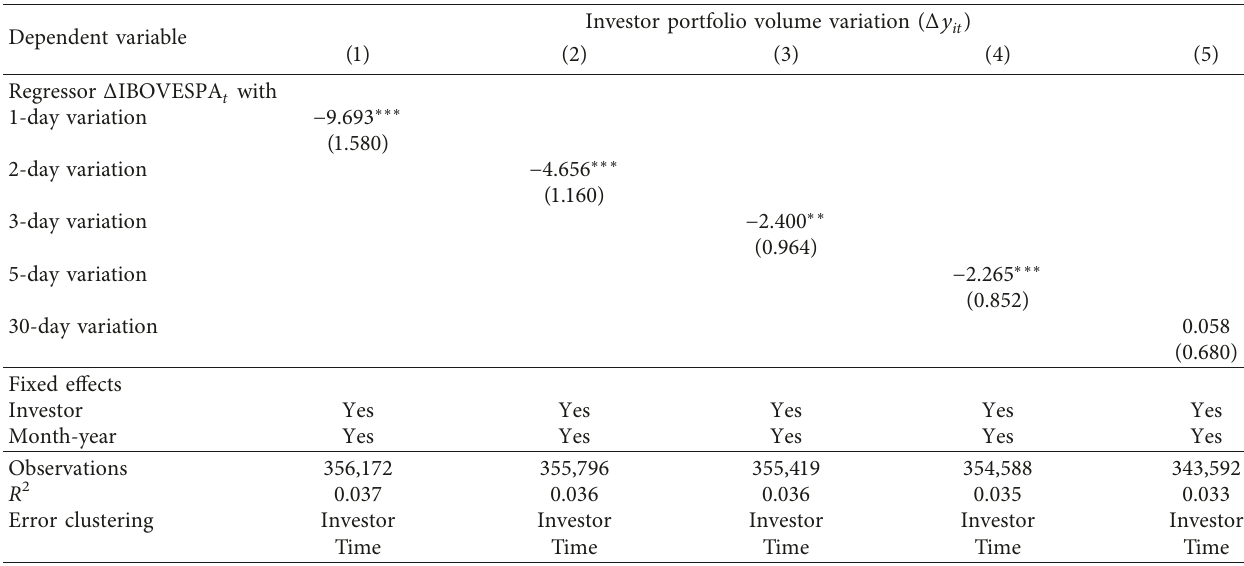
Table 2: Output from Regression (4). We ask how investors respond to changes in the IBOVESPA index. We only use changes rather than past averages because the former has greater prediction power as reported by our feature selection procedure. The dependent variable is the variation of portfolio investment volume of investor i at time t in the Brazilian stock market from the beginning of 2016 to the end of 2018. Regressors are 1- (1), 2- (2), 3- (3), 5- (4), and 30-day (5) IBOVESPA index variations. The panel is on a daily frequency basis. Following Petersen [50], we double-cluster standard errors at the investor and time levels. Significance levels: ∗ p < 0 . 10, ∗∗ p < 0 . 05, and ∗∗∗ p < 0 .